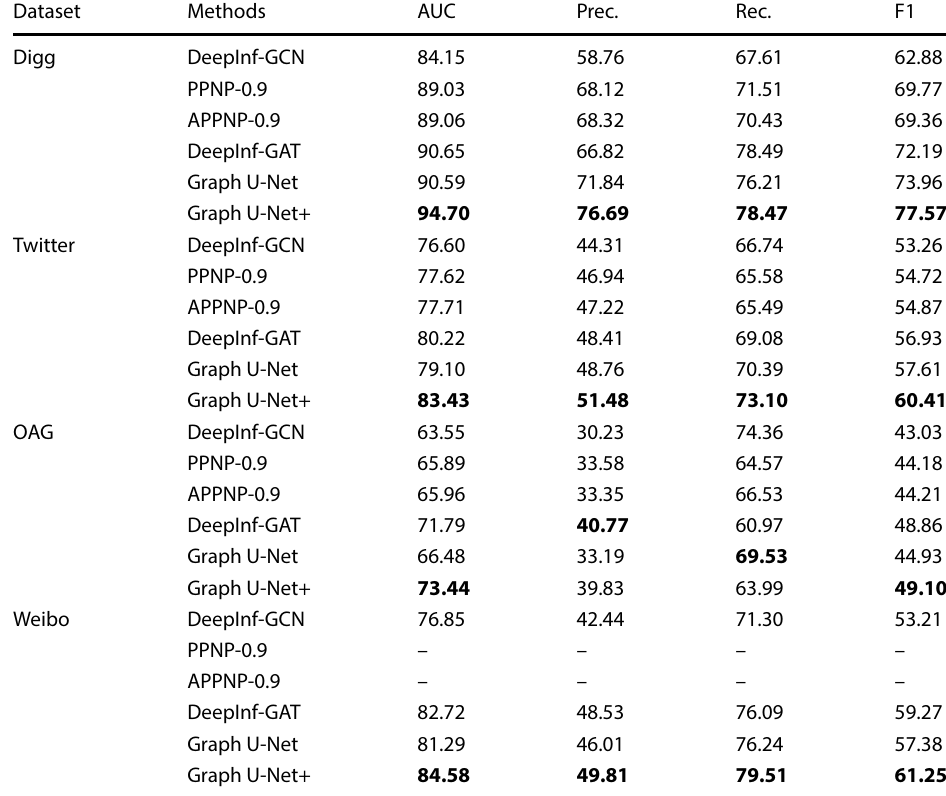
Table 3 Social behavior prediction performance of different methods on four large real-world